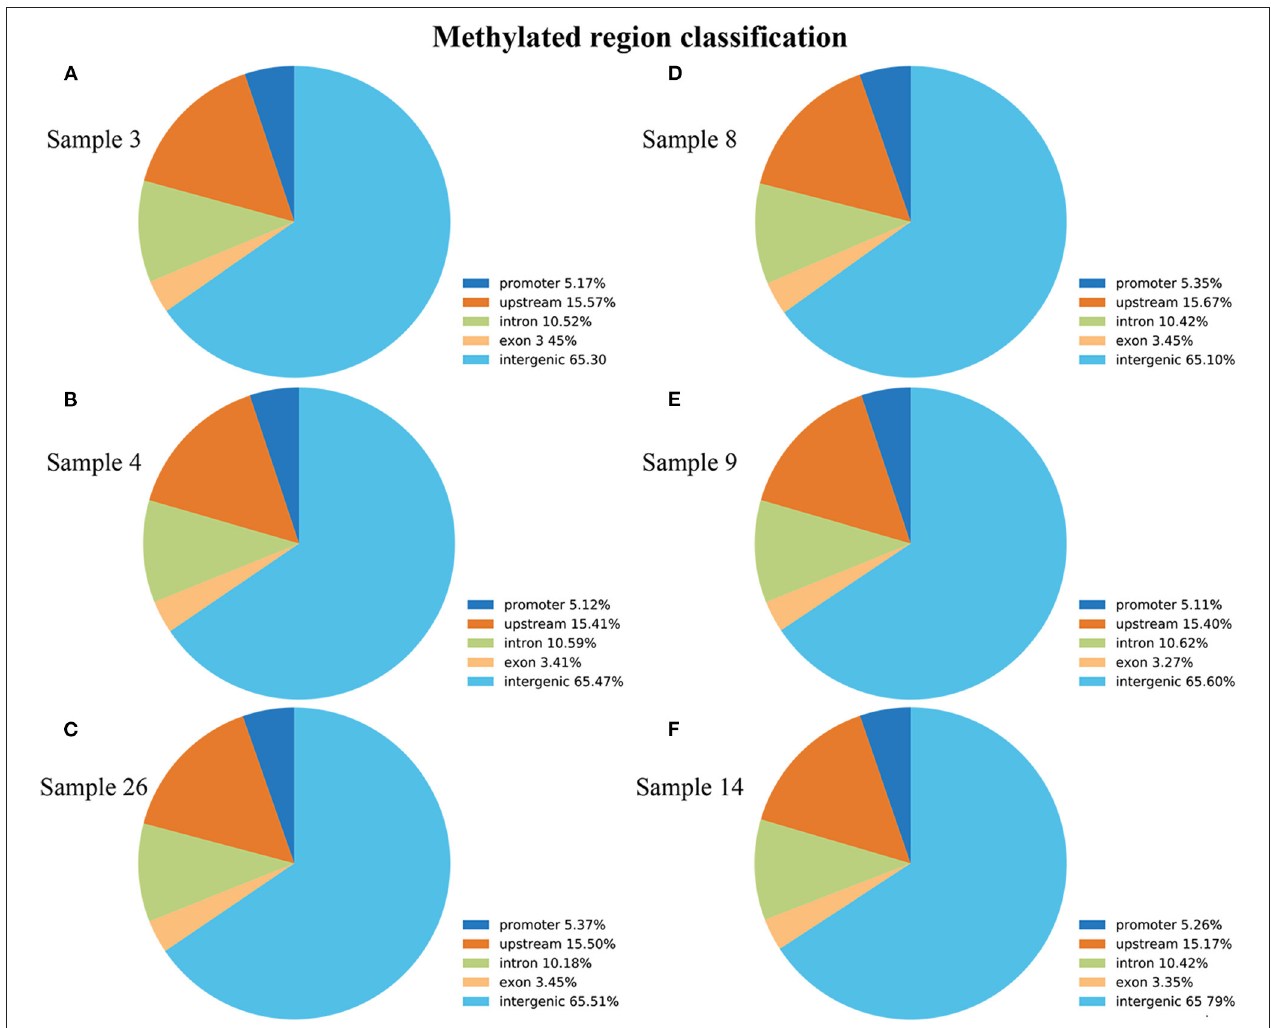
FIGURE 3 | Distribution of methylation peaks in different genic regions of each sample, including promoter, intro, exon, intergenic, and upstream regions. (A–C) ALV-J-negative chickens; (D–F) ALV-J-positive chickens. Similar to the genic distribution of methylation peaks, the differentially methylated regions (DMRs) were most often located in the intergenic region in both